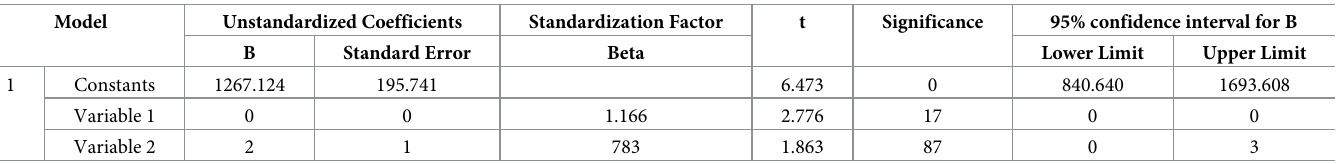
Table 7. Test and value of the coefficient a.